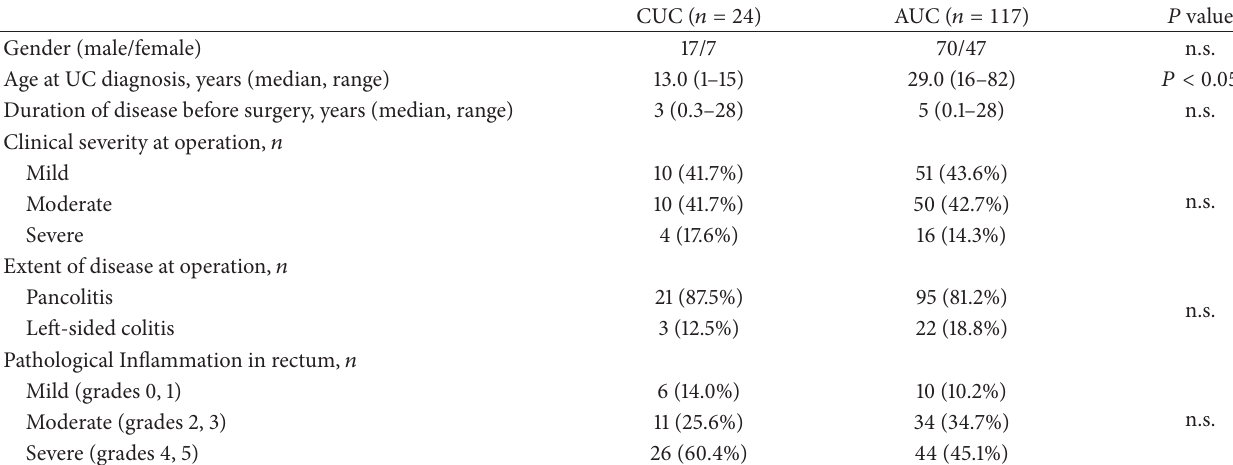
Table 1: Patients